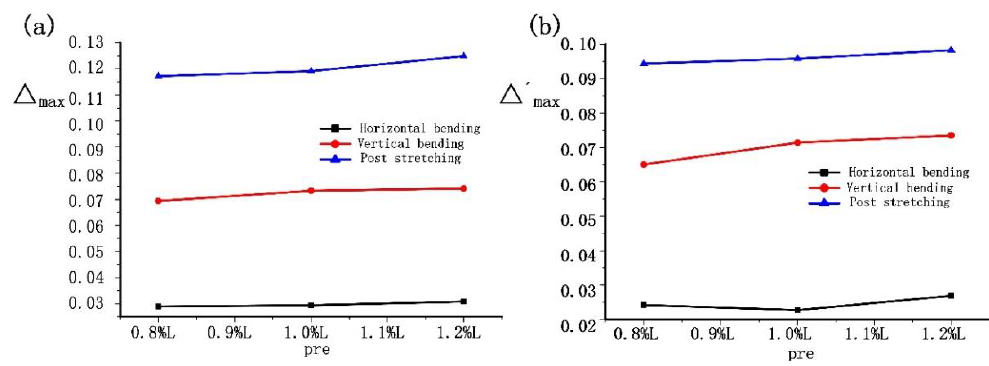
Figure 7. Effect of pre-stretching on thinning. ( a ) Outer web. ( b ) Inner web.